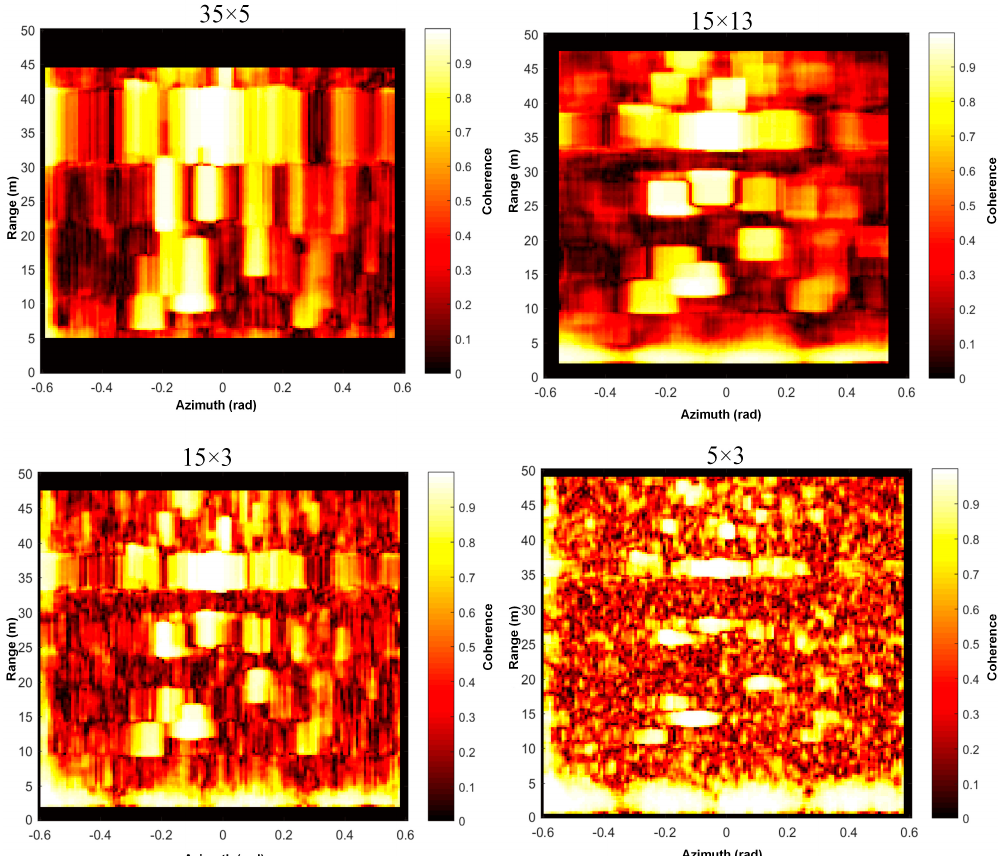
Figure 8. Different coherence window calculation size was tested. For example, “35 × 5” means in the range direction 35 pixels and in 5 pixels in the azimuth direction were used to calculate coherence via Equation (9).